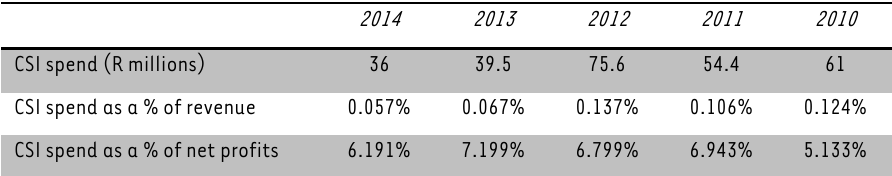
TABLE 8: Pick n Pay CSR/CSI spending from 2010 to